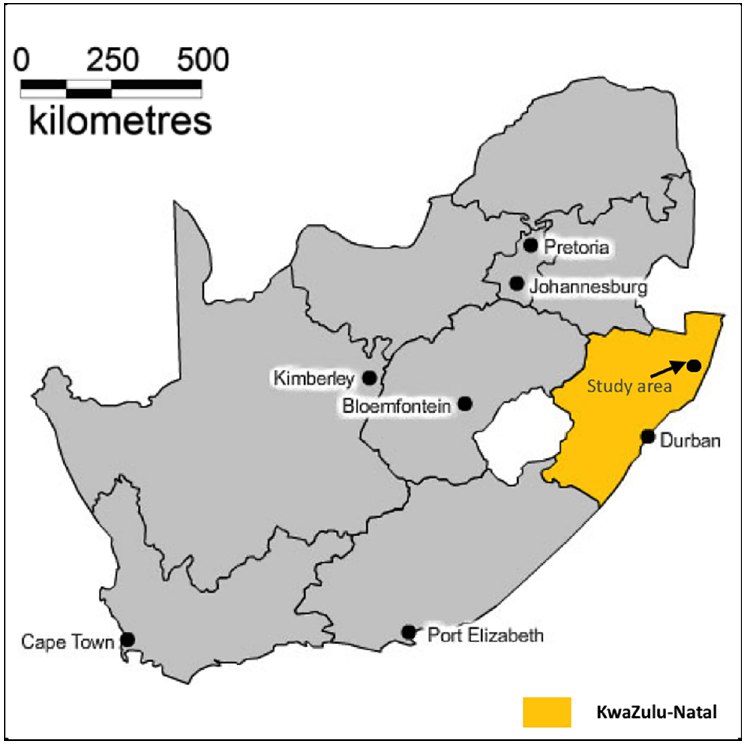
Fig 1. Location of the Africa Health Research Institute (AHRI) study area in KwaZulu-Natal Province, South Africa.